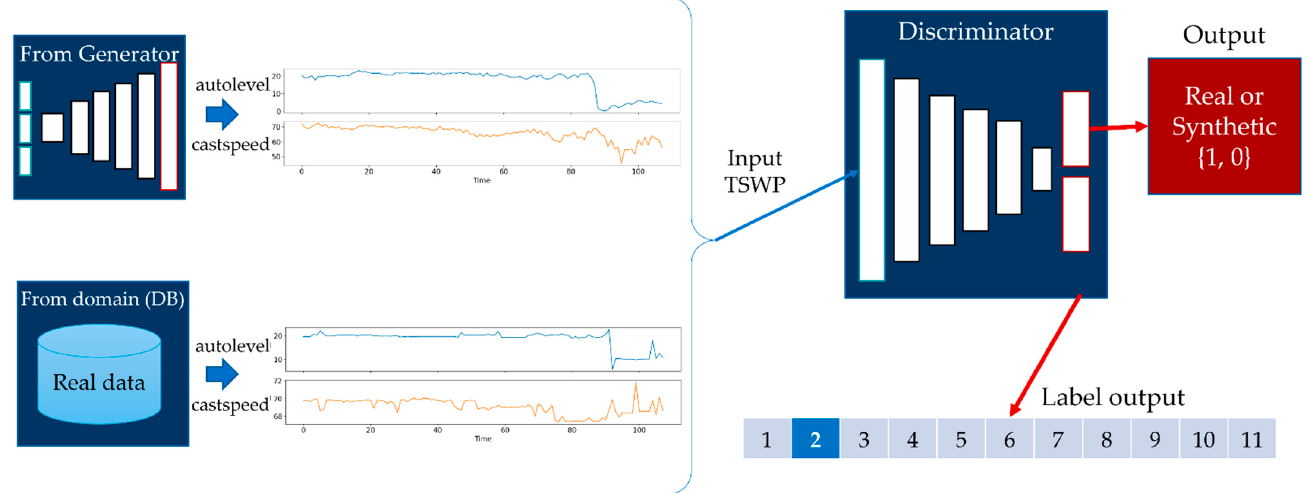
Figure 7. Discriminator model of AC ‐ GAN for the casting process.